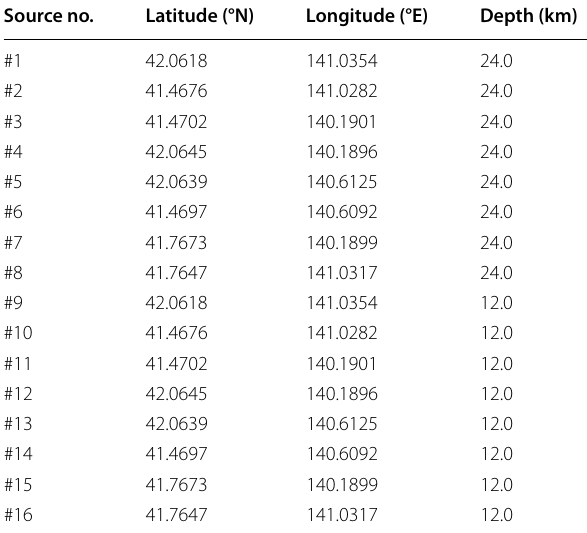
Table 4 Locations of hypothetical sources for evaluating site